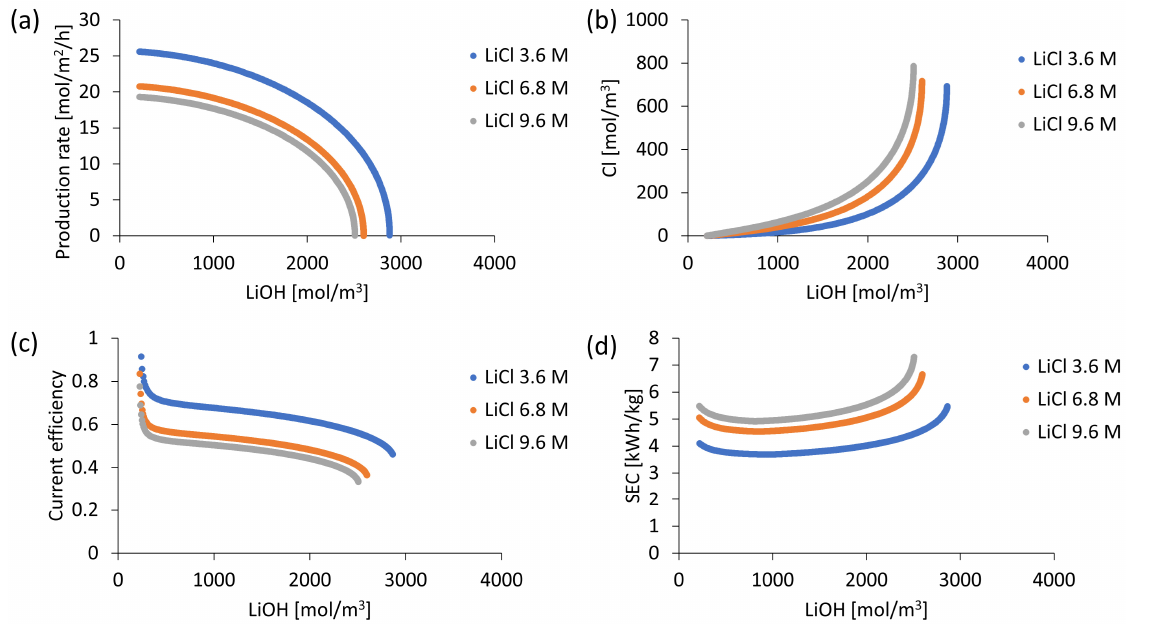
Figure 8. Simulation results for three different LiCl concentrations at a current density of 1000 A/m 2 : ( a ) LiOH production rate; ( b ) Cl − concentration; ( c ) Current efficiency; ( d ) Specific electricity con- sumption (SEC).